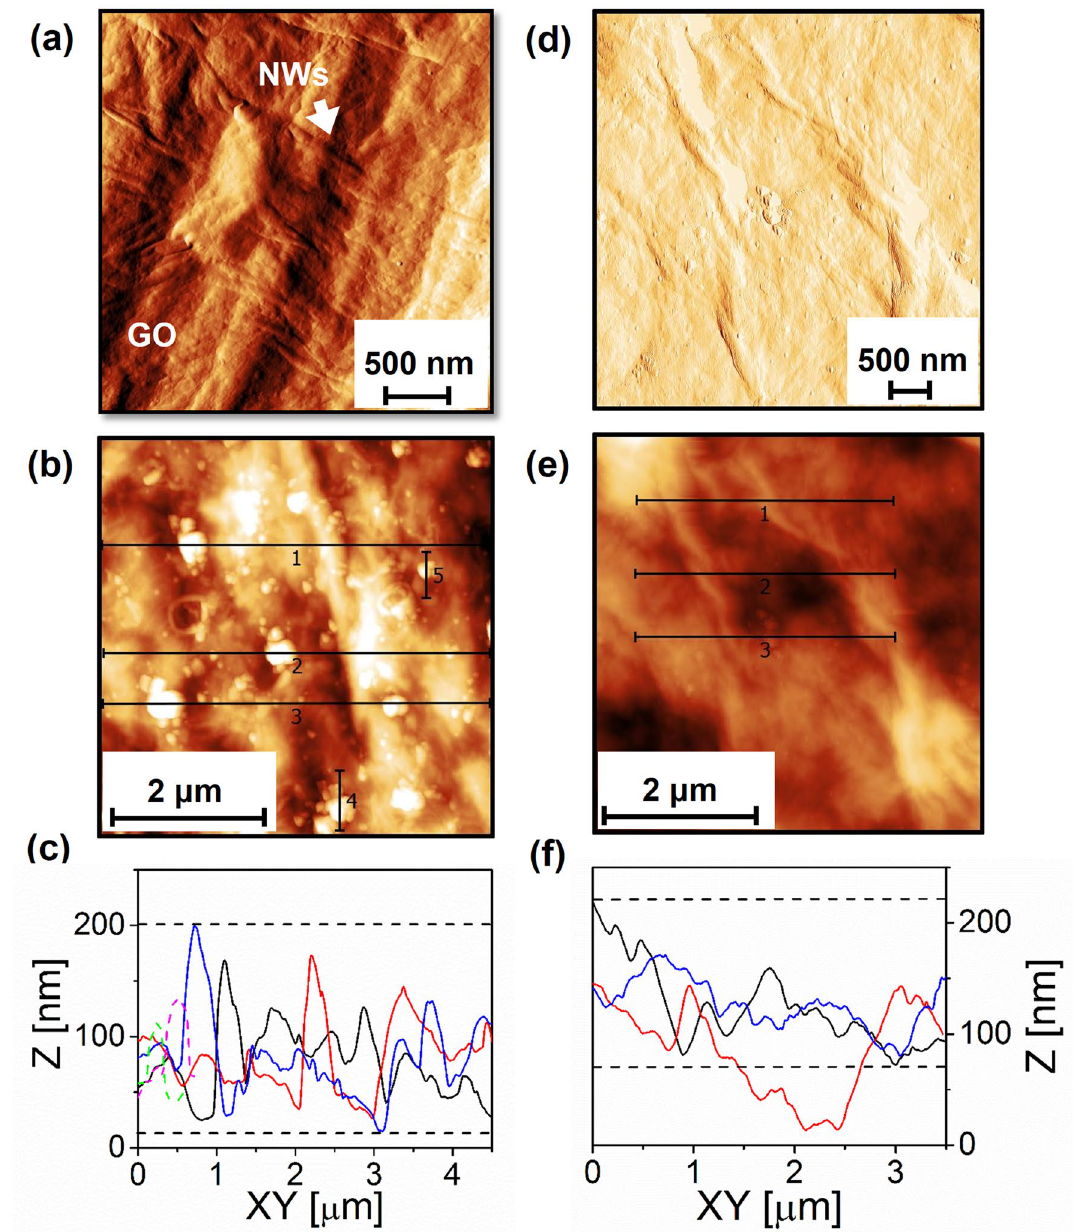
Figure 2. For composite: ( a ) AFM image of amplitude, ( b ) AFM topographic image and ( c ) its corresponding AFM height profile. For GO: ( d ) Amplitude image, ( e ) AFM topographic image and ( f ) its corresponding AFM height profile. For ( c ) and ( f ): Continuous lines correspond to Profile 1 (black), Profile 2 (red), Profile 3 (blue); and Dashed lines in ( c ): Profile 4 (Magenta), Profile 5